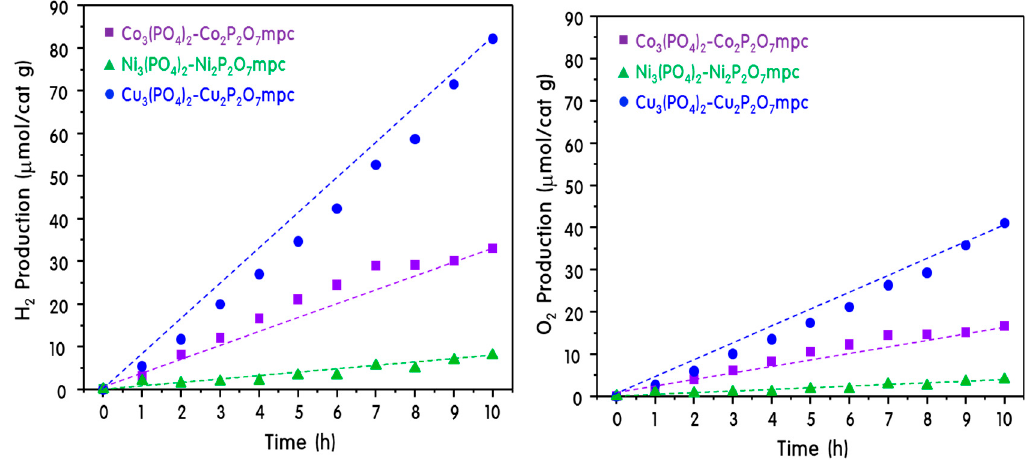
Figure 7. Evolutions of H 2 and O 2 over M 3 (PO 4 ) 2 -M 2 P 2 O 7 mpc (M = Co, Ni, and Cu).